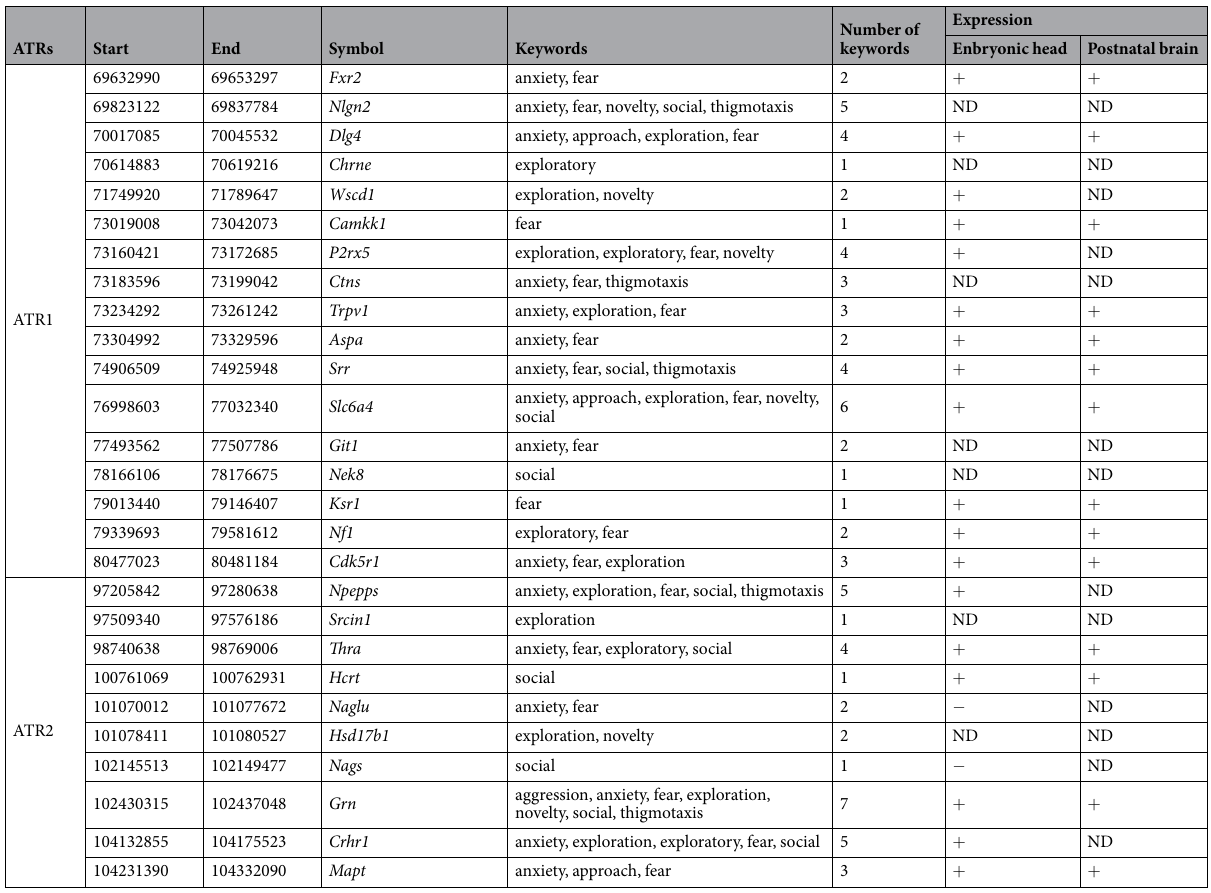
Table 2. Profiles of 28 genes within ATR1 and ATR2 using keywords related to tameness. ND, no data was registered. “ − ”, expression was not detected. “ + ”, expression was registered in the Gene Expression Database. The gene information was obtained from Gene Expression Database in Mouse Genomics